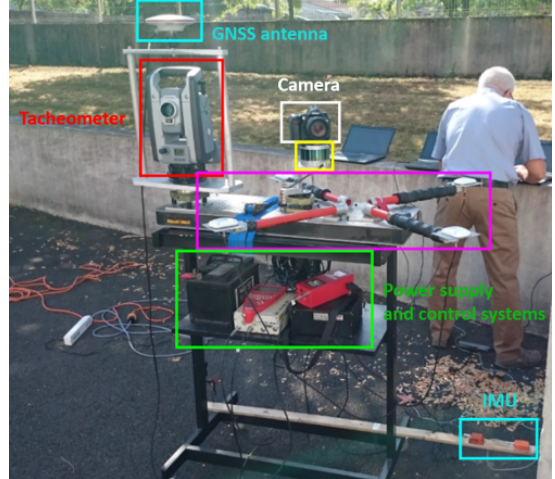
Figure 4. View of the test